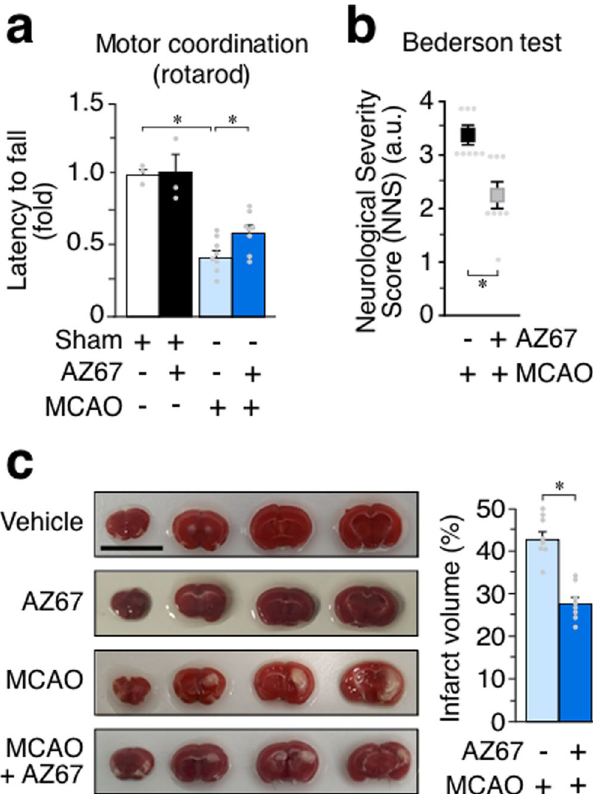
Figure 4. In vivo AZ67 administration protects mice against neurological impairment, motor discoordination and brain injury caused by a brain ischemia/reperfusion model. (a) Motor coordination, analysed 24 h after a transient MCAO episode in mice, revealed a ~40% performance (rotarod) when compared with the sham- operated animals (100% performance). This effect was significantly prevented by the intravenous administration of AZ67 (60 mg/kg of body weight) immediately after the ischemic episode (~60% performance). (b) Neurological Severity Score (NNS), examined 24 h after a transient MCAO episode in mice, revealed severe neurological deficit according to the Bederson test when compared with the sham-operated animals. This effect was significantly prevented by the intravenous administration of AZ67 (60 mg/kg of body weight) immediately after the ischemic episode. (NNS = 0 both for vehicle or AZ67 in the sham-operated animals). (c) Infarcted brain volume, analysed 24 h after a transient MCAO episode in mice, was ~43% of the brain of the sham- operated animals. This effect was significantly prevented by the intravenous administration of AZ67 (60 mg/kg of body weight) immediately after the ischemic episode (~27% of infarcted volume). Left panel shows pictures of the brain sections of a representative animal for each experimental group. Bar, 1 cm. In all cases, data are range test). See also Supplementary Data 1 and Statistics Table